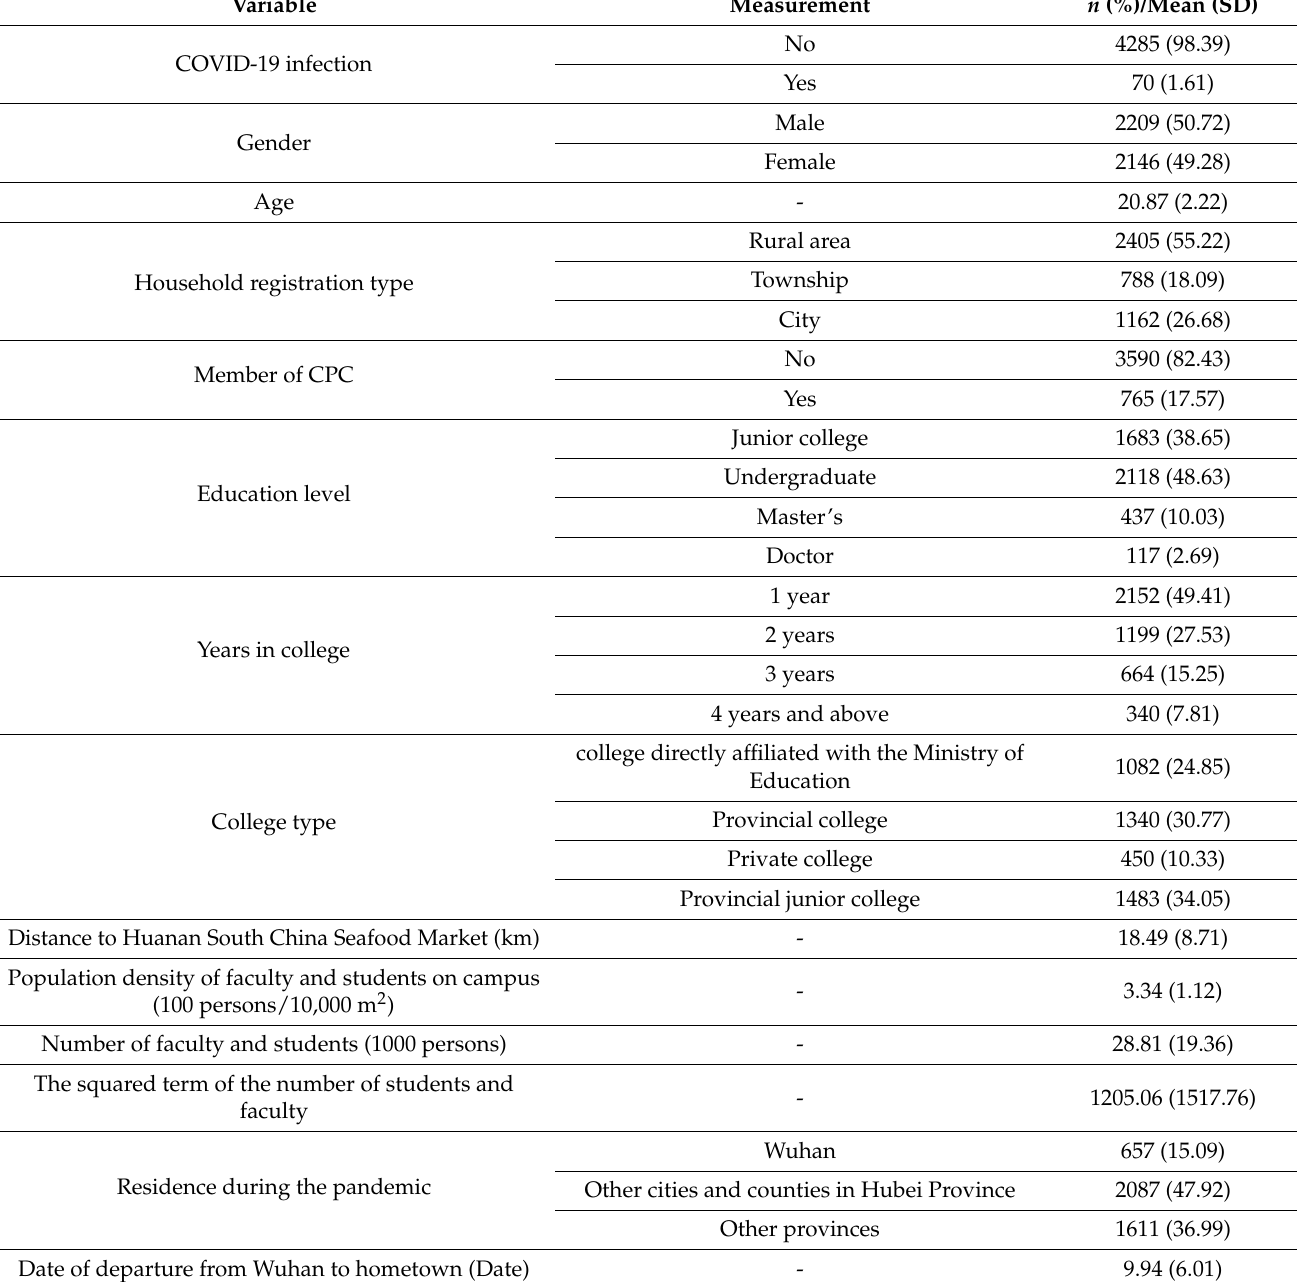
Table 1. Variable statistical description ( n =